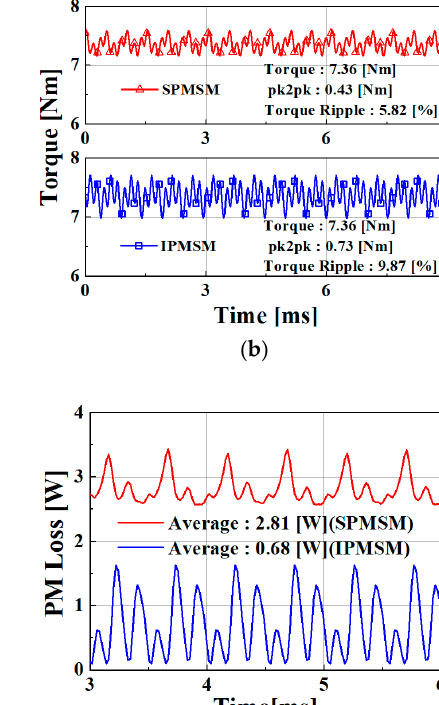
by the magnetic flux density analysis results in Figure 7.